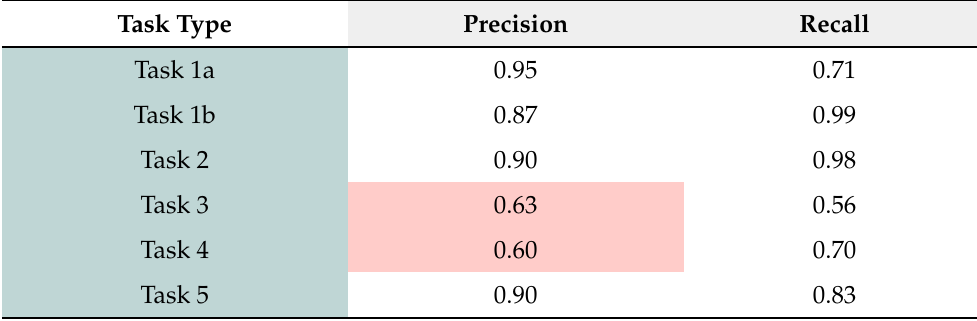
Table 3. Precision and recall for Participant 5, based on the 6 label classification.